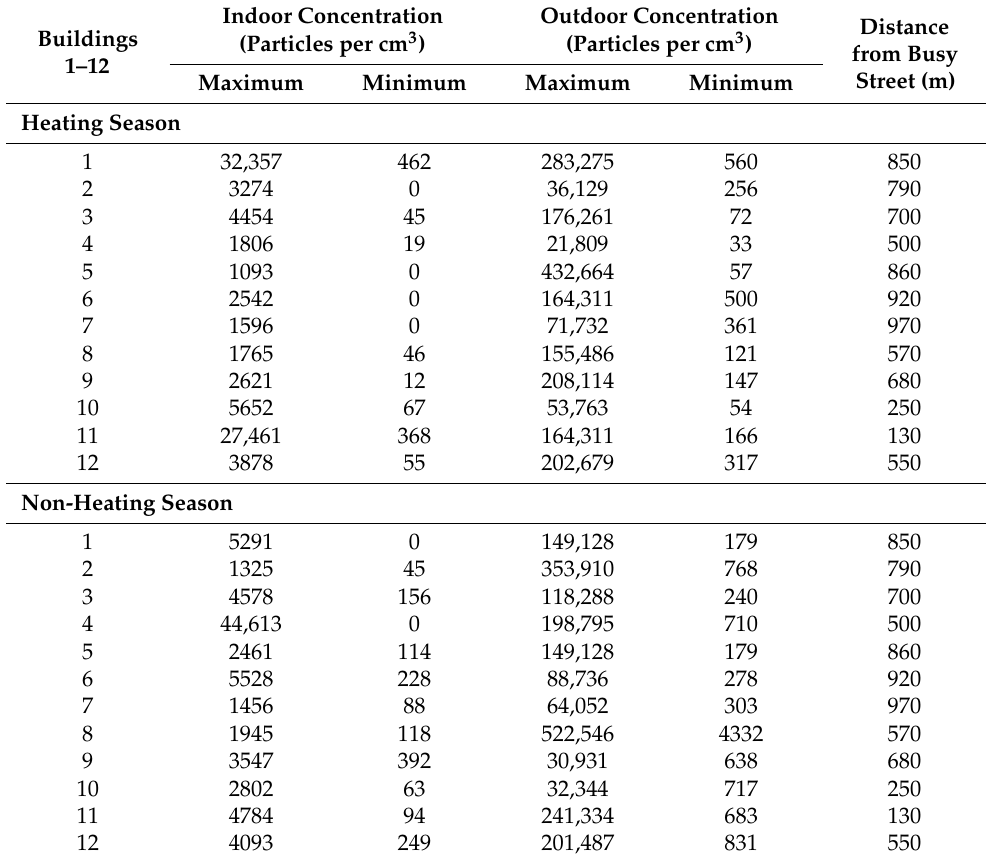
Table 3. Maximum and minimum concentrations measured indoors and outdoors during the heating and the non-heating